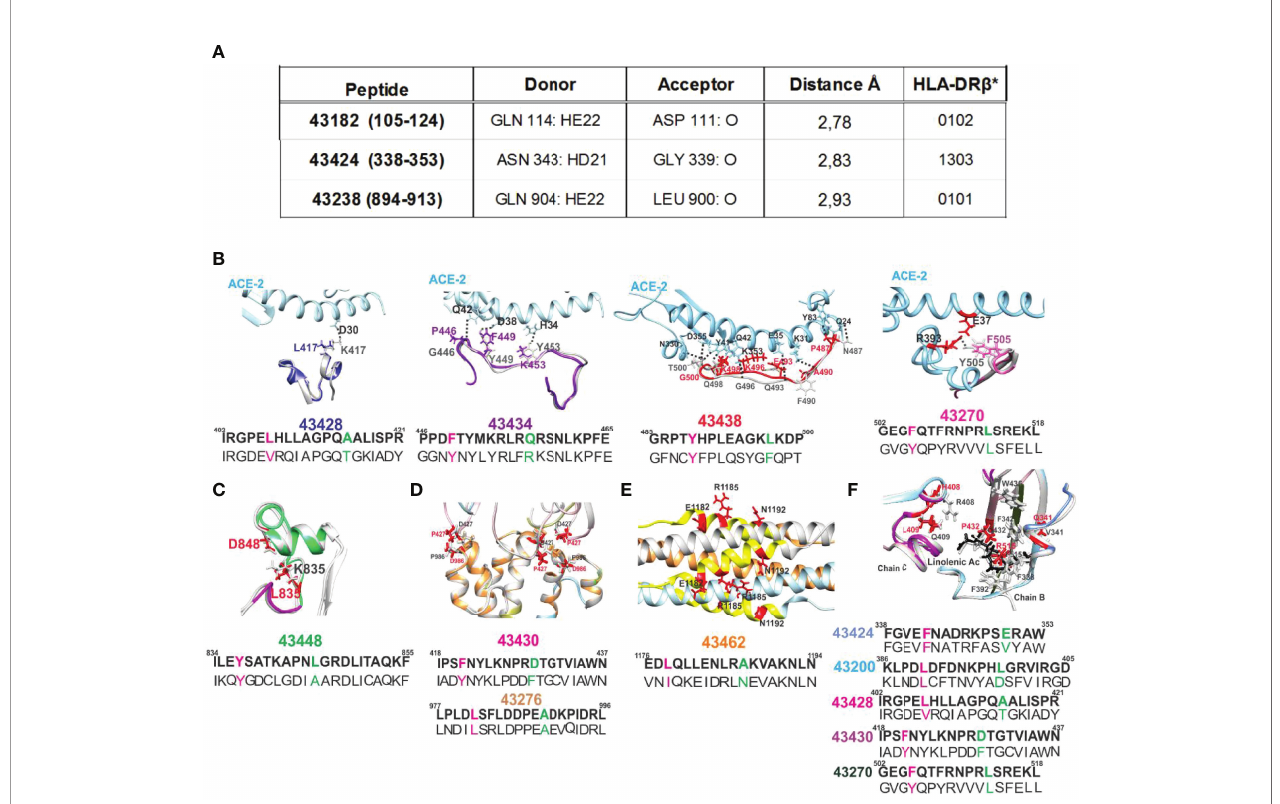
FIGURE 10 | H-bonds regarding SM-COLSARSPROT peptides and ACE2 receptor (pale blue) interaction with native (grey) and modi fi ed peptides (colour). (A) The n ! p * delocalisation effect involved polar aa N and Q and SC-BB H-bonds forming during electron interactions. Donor and acceptor atoms are shown with Å distance from 43182, 43424, and 43238 and their corresponding HLA-DR b 1* molecules. Broken H-bonds and structural changes in interactions critical for S protein stabilisation. (B) The ACE2 receptor (pale blue), S protein native fragment (grey), and modi fi ed peptide minimised fragments (43428, dark blue; 43434, purple; 43438, red; and 43270, pink). Black dots show canonical ACE2 H-bonds with S protein. Replaced aa coloured as above, showing disruption of S peptide H-bond with receptor. (C) Modi fi ed peptide 43448 (green) location in the FPPR, showing aa involved in a salt bridge (black numbers) and replaced aa (red), indicating this salt bridge ’ s rupture. (D, E) Location of modi fi ed peptides involved in trimer, HR1, and HR2 region stabilisation and modi fi ed aa in red. (F) The location of aa involved in S protein hydrophobic interaction with linoleic acid (black structure). Red numbers on the structure show aa replaced in modi fi ed peptides, indicating lack of hydrophobic interactions. All images show modi fi ed aa sequences in bold letters below the native sequence; superscript numbers indicate their location in the